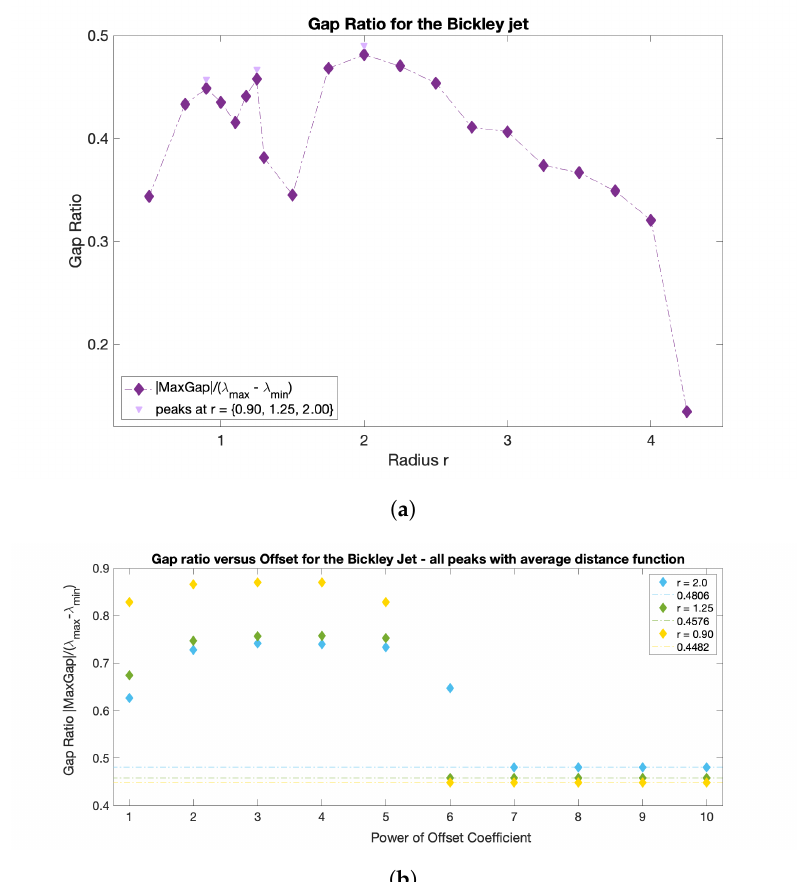
Figure A1. ( a ) Step 1 of the spectral clustering protocol for the Bickley Jet example: normalized eigengap as a function of r with the average distance function. ( b ) Step 2 of the spectral clustering protocol for the Bickley Jet: sweep of offset coefficients 10 n for the gap ratio peaks in ( a ) at r = 0.90, r = 1.25 and r = 2.00 with the average distance